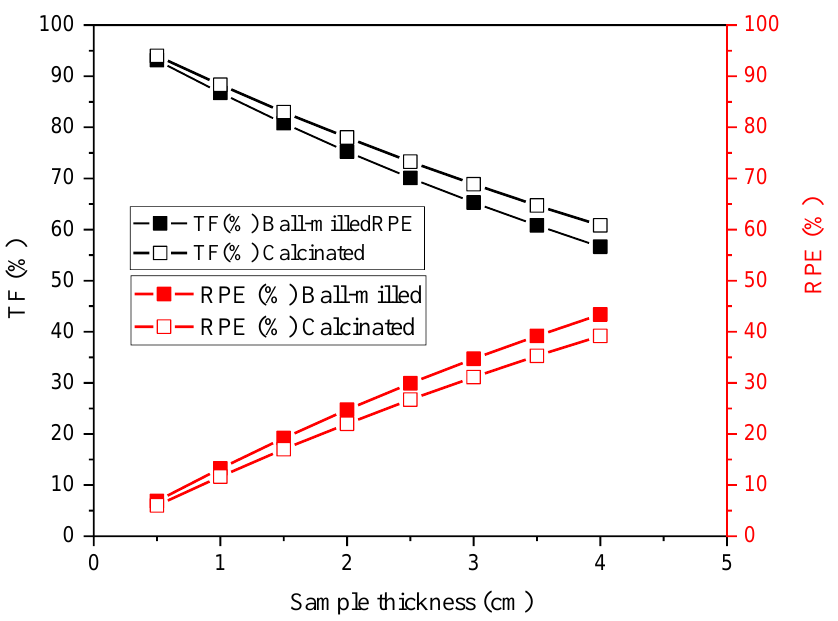
Figure 13. Variation in the TF and RPE versus the sample thickness at a pressure rate of 50.98 kg/cm 2 .